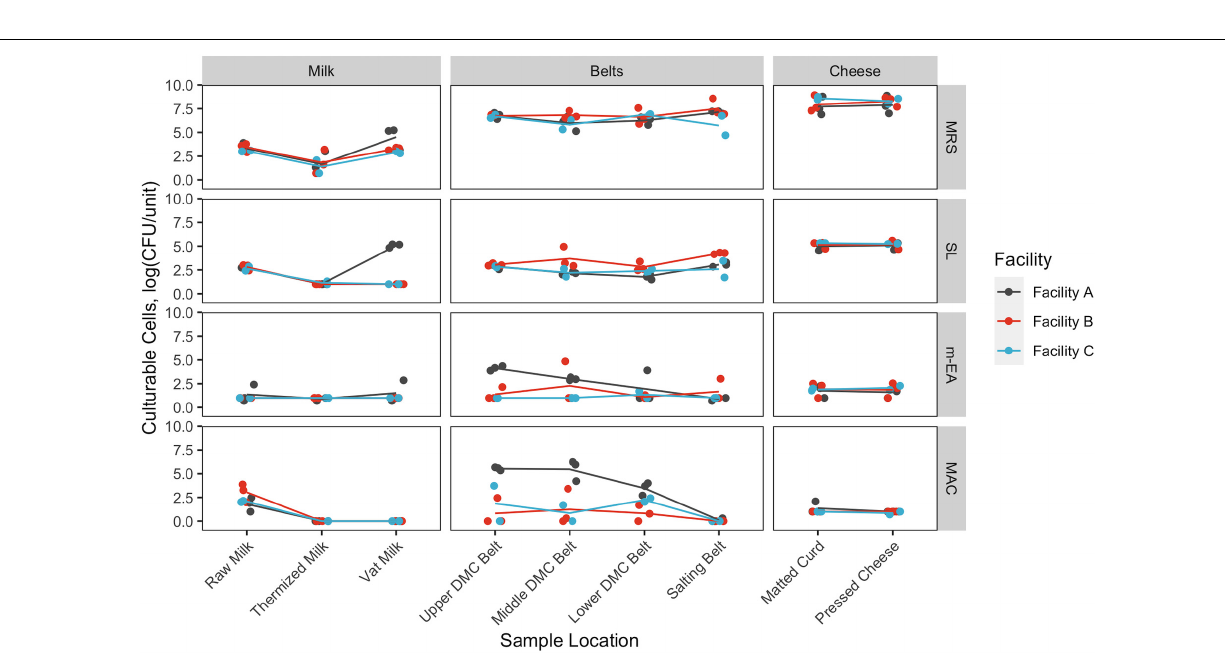
Frontiers in Microbiology |